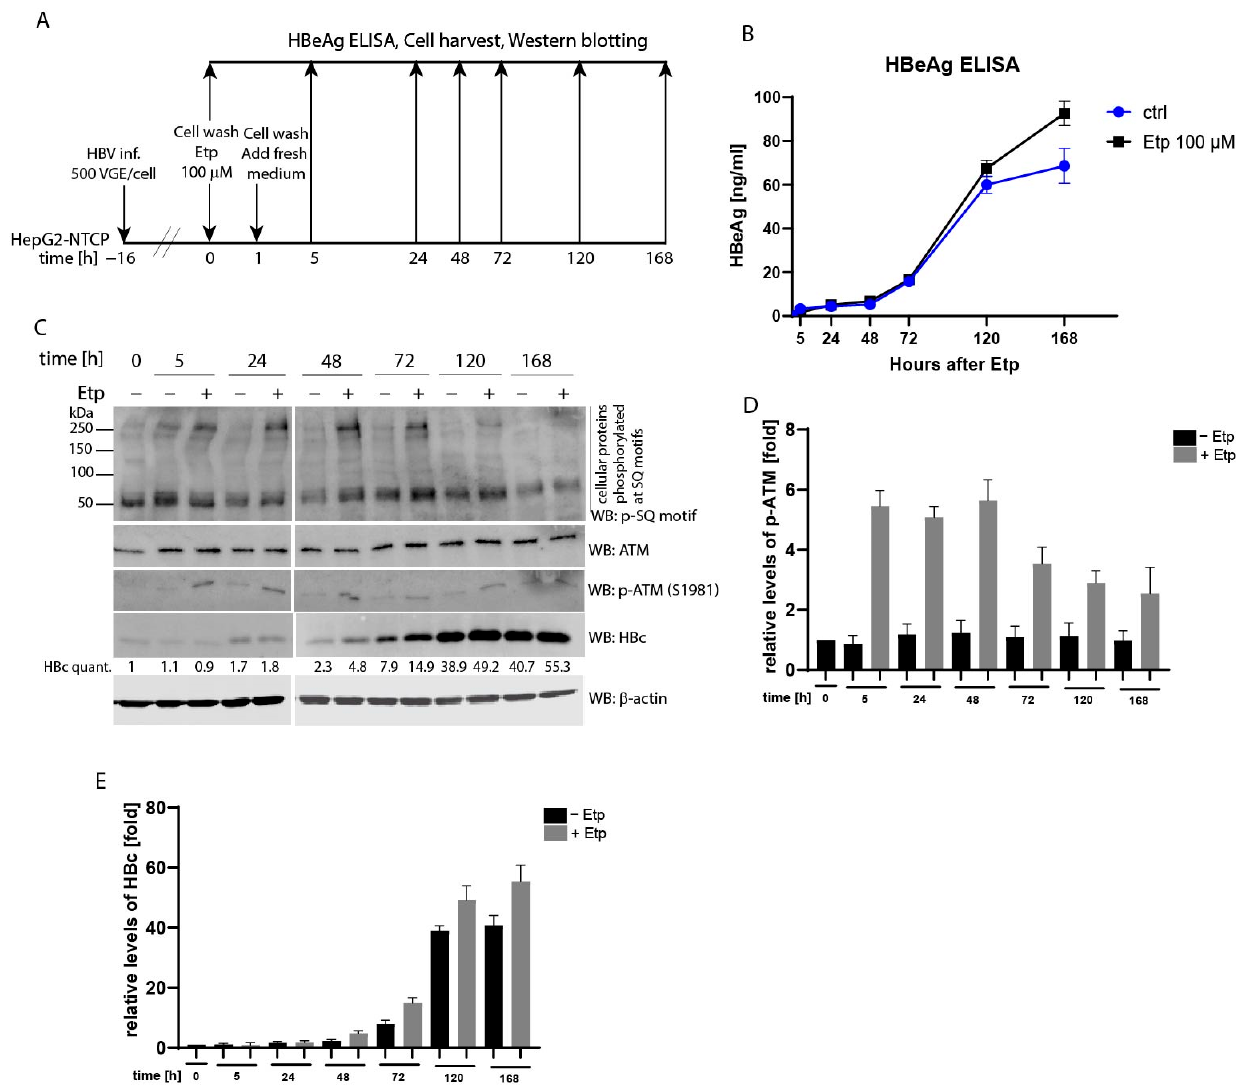
Figure 5. Etoposide treatment of HBV-infected HepG2-NTCP cells stimulates HBV replication. ( A ) The experimental outline: HepG2-NTCP cells were infected with HBV (MOI 500 VGE per cell) and treated with 100 µ M etoposide (+) for 1 h, or left untreated ( − ). At various time-points (0, 5, 24, 48, 72, 120 and 168 h) after addition of etoposide, the levels of HBeAg ( B ) in the culture supernatants were analyzed by enzyme-linked immunosorbent assay (ELISA). Data is shown as mean ± standard deviation for two independent experiments. ( C ) The protein lysates (20 µ g) were isolated at different time-points and were analyzed by Western blot using antibodies against a phospho-SQ motif (p-SQ), HBc, ATM, p-ATM and β -actin (loading control). The intensity of the HBc protein signal was quantified and normalized to the corresponding level of β -actin. The amount of the HBc protein in non-treated control cells at time-point 0 h was set to 1. The HBc quant. values were calculated as mean of two independent infection experiments. ( D , E ) The densitometric analyses of the ATM phosphorylation signal (p-ATM; shown in ( D )) and the HBc protein levels (shown in ( E )) that were determined in ( C ) using Image Studio Lite Software. The data are shown as mean ± SD from two independent